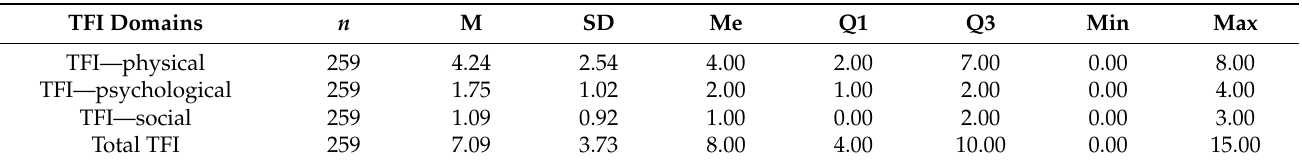
Table 3. Assessment of physical, psychological, and social domains by the Tilburg Frailty Indicator (TFI) in HBP patients. TFI Domains